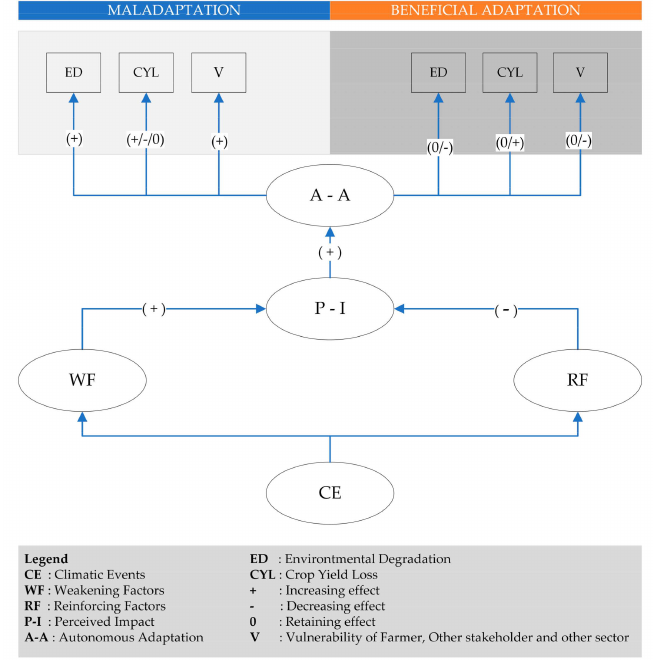
Figure 1. The relationship between climate change risk perception, autonomous adaptation, and adaptation